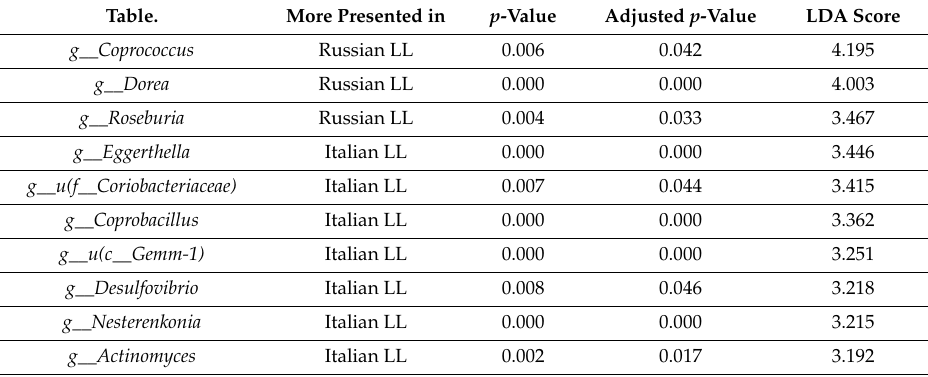
Table 3. Comparison of the LL microbiota composition of the centenarians from Russia and Italy at the genus level (Wilcoxon rank-sum test).